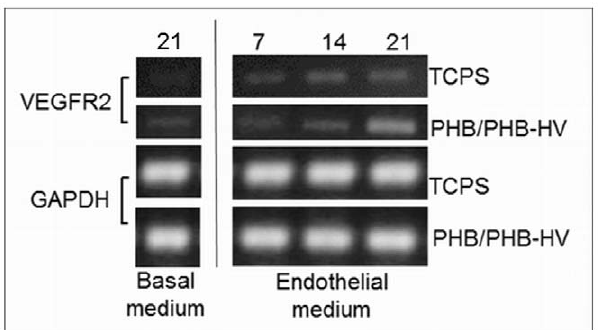
Figure 6. RT-PCR analysis of VEGFR2 mRNA expression during endothelial differentiation on the electrospun PHB/PHB-HV fiber mesh and TCPS. Total RNA was extracted from cells cultured on basal medium and endothelial differentiation medium for analysis of VEGFR2 mRNA expression. The cells were cultivated up to 21 days.